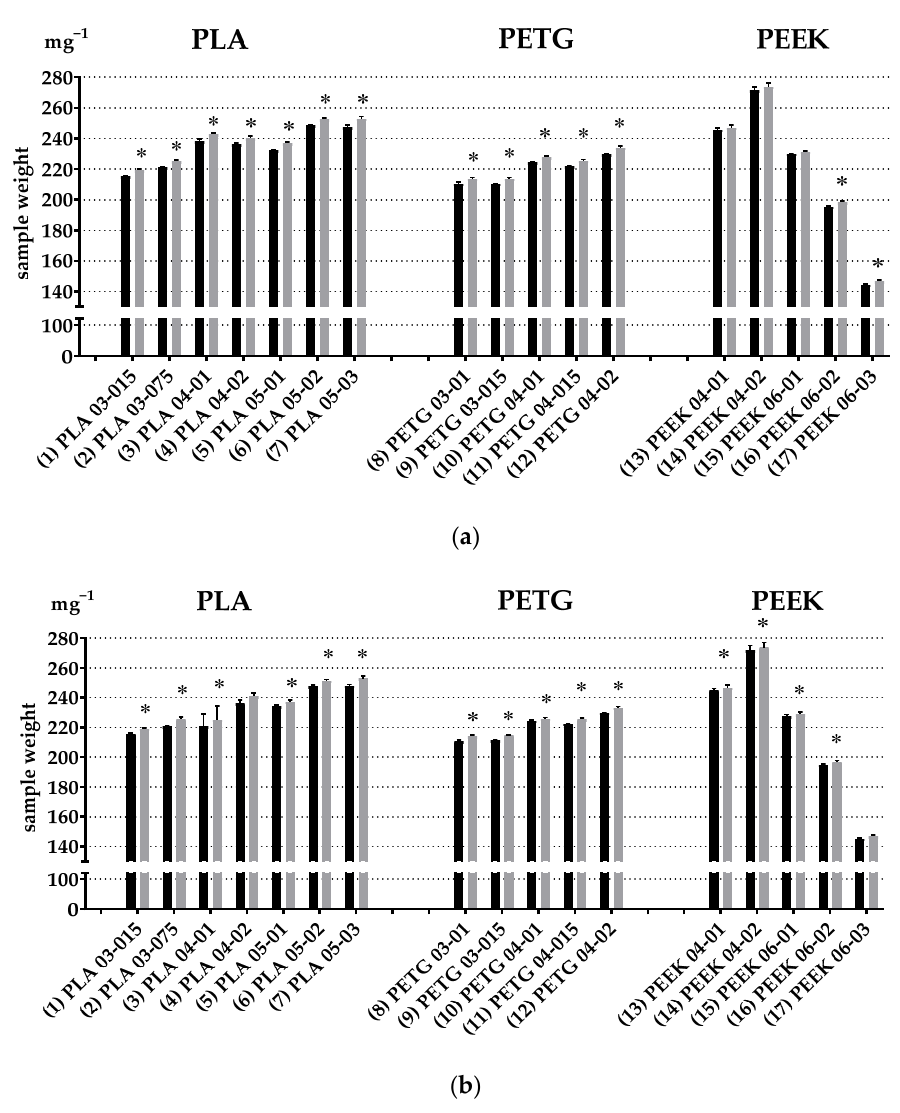
Figure 5. * p < 0.05 paired Student t -test between weight of polymer samples before (black bar) and after (grey bar) 12-h cultivation with bone marrow cells ( a ) and peritoneal cells ( b ).